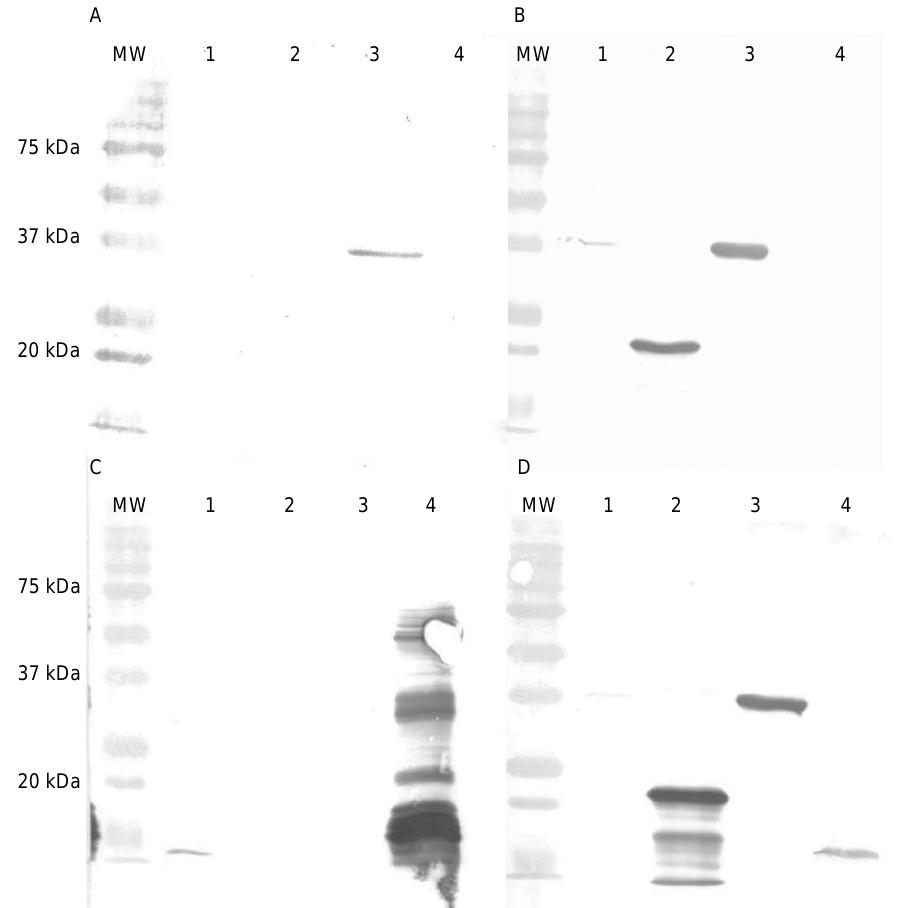
Figure 7. Western blotting analysis using VACV Elstree (Lane 1), #F1 (Lane 2), F13 (Lane 3) and A27 (Lane 4) proteins. The scFv 3E2 ( A ) detected the whole F13, while the mAb 15B6 ( B ) showed a reaction on the VACV Elstree, #F1 and the whole F13 protein. The control mAb 5B4/2F2 ( C ) was used and detected VACV Elstree and the recombinant A27 protein. The his-tag Ab ( D ) served as positive control and bound to all recombinant proteins. MW was Precision Plus Protein Standard (Bio-Rad).